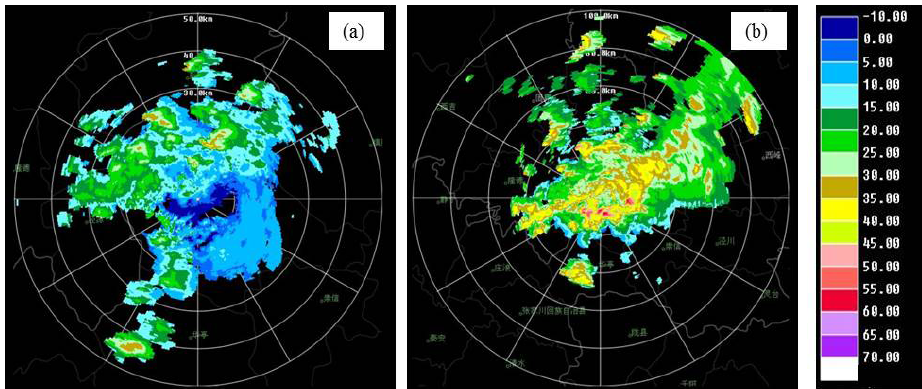
Figure 3. Composite reflectivity of radar, (a) 16:14; (b)